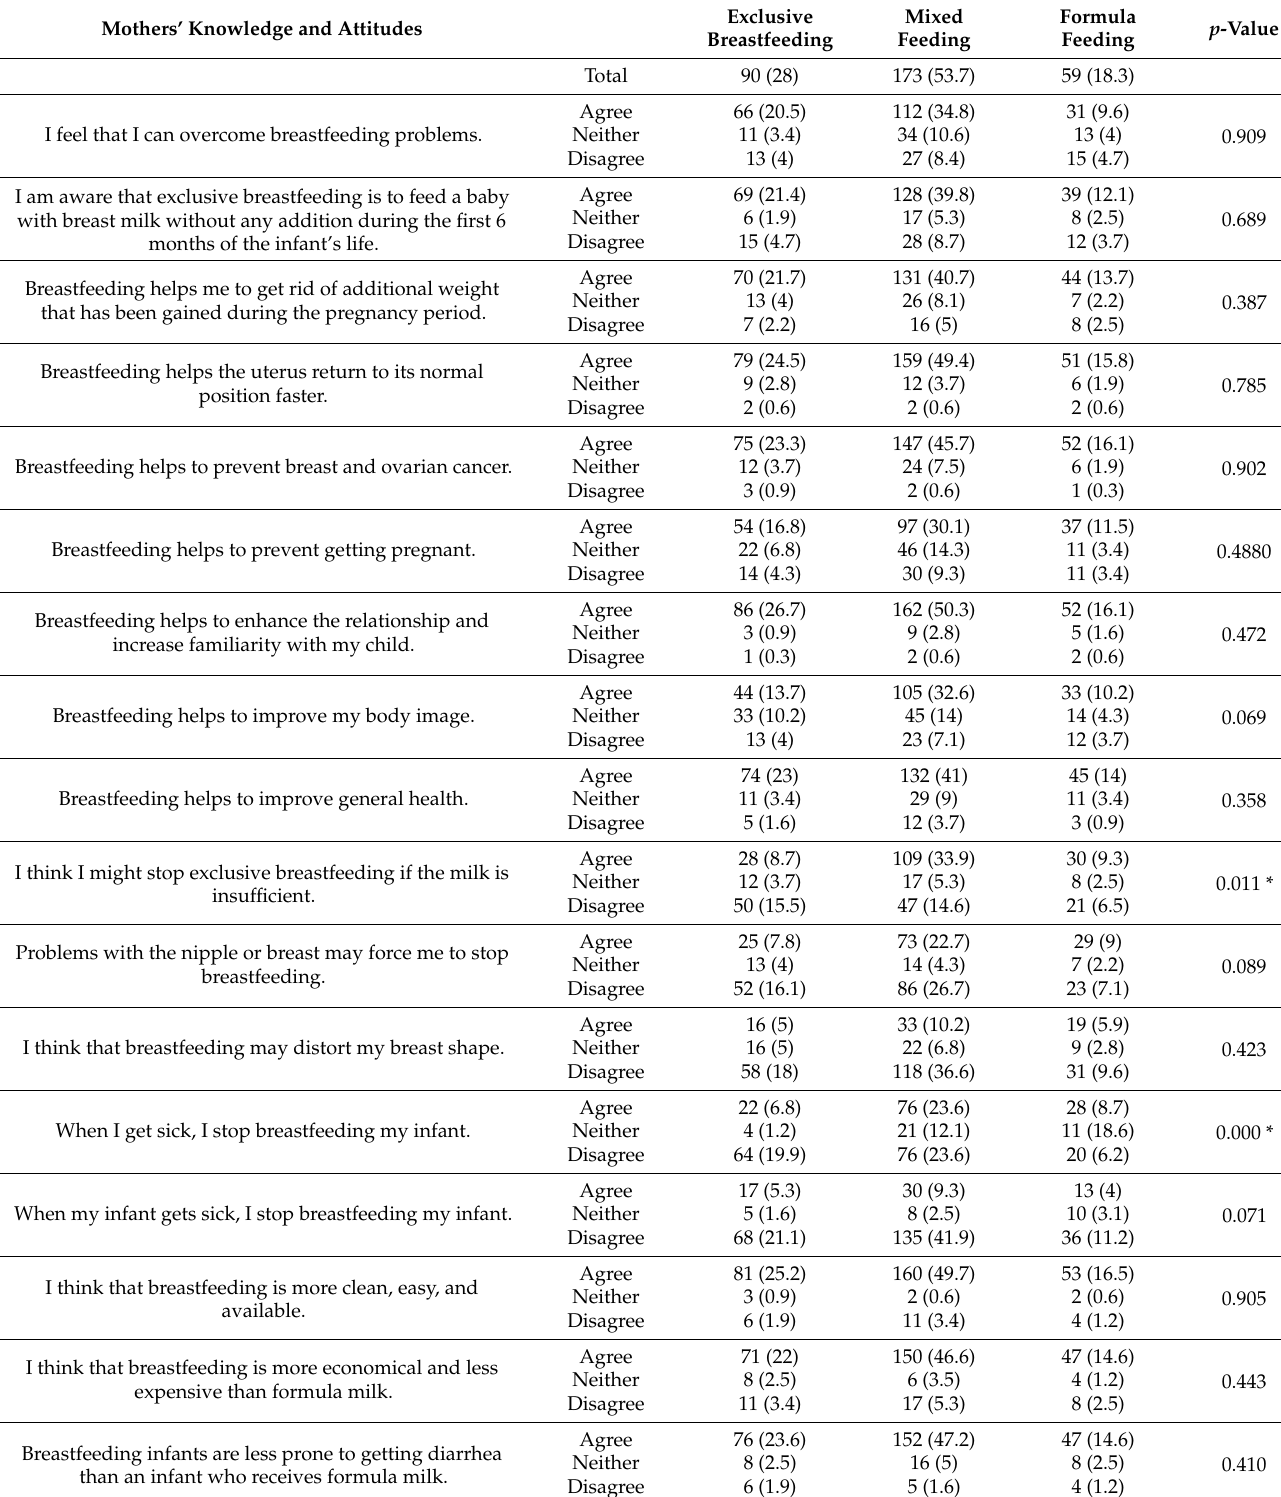
Table 2. Saudi mothers’ knowledge and attitudes about breastfeeding in relation to their infants’ actual feeding practices for the first six months of their infants’ lives in Riyadh, Saudi Arabia. Mothers’ Knowledge and Attitudes